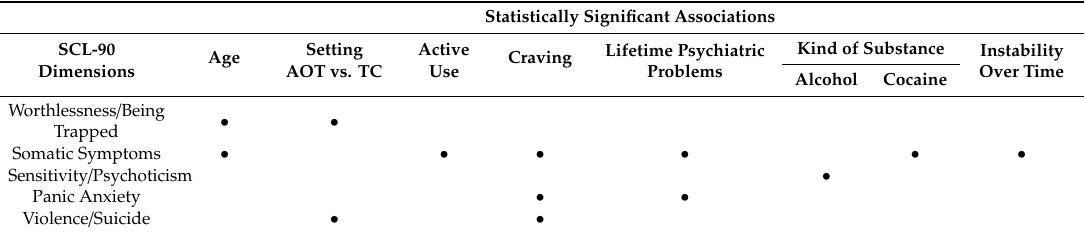
Table 3. Statistically significant associations between SCL-90-based psychopathological dimensions that are specific to substance use disorder and other demographic and clinically pertinent